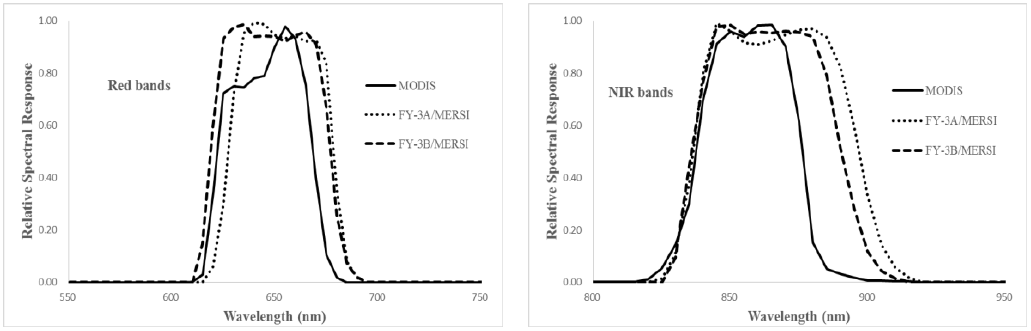
Figure 5. The relative spectral responses of the MERSIs and MODISs in VNIR bands.